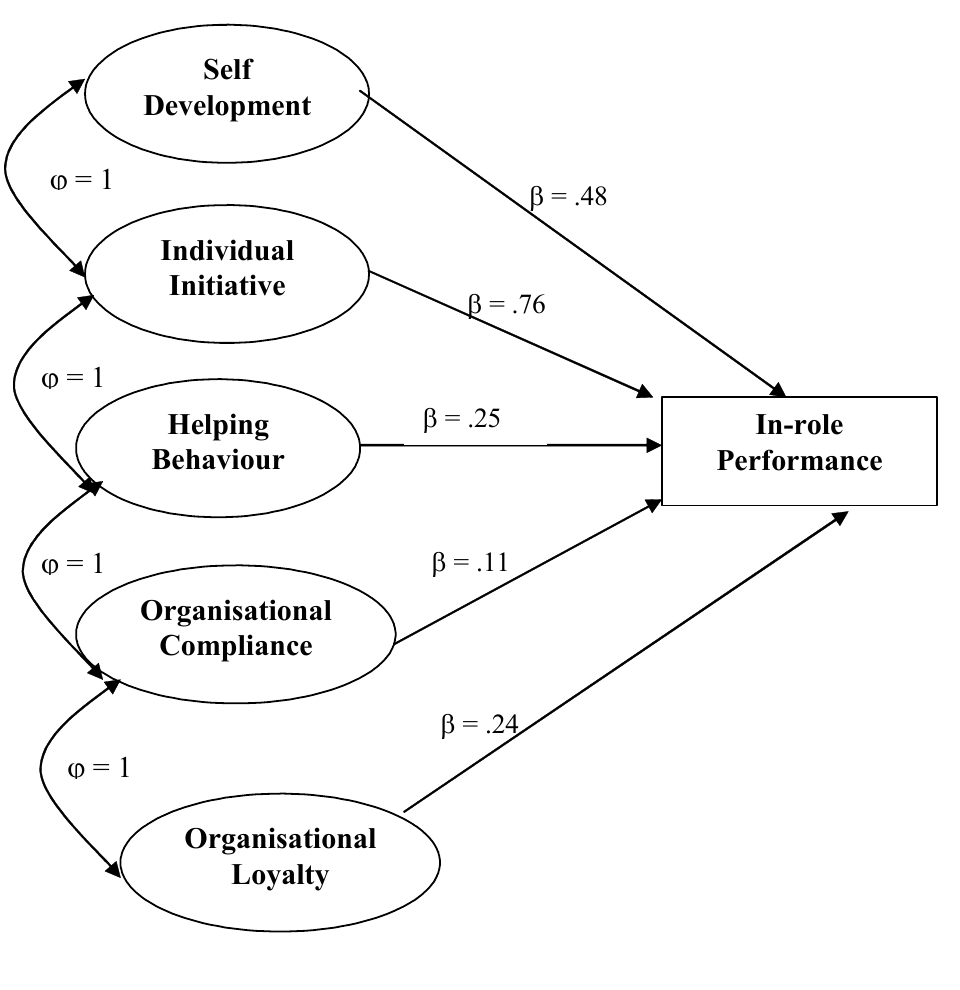
Figure 3: Extra-role/In-role performance